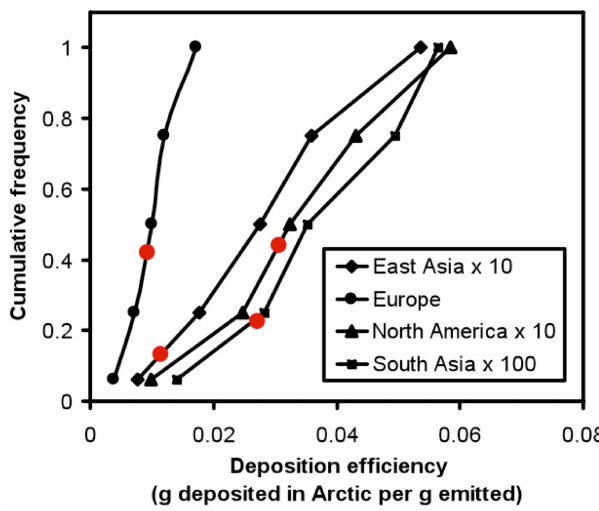
Fig. 9. Distribution of ensemble results for springtime Arctic de- position (March–April–May) (from Shindell et al., 2009), and com- parison of CAM results (red